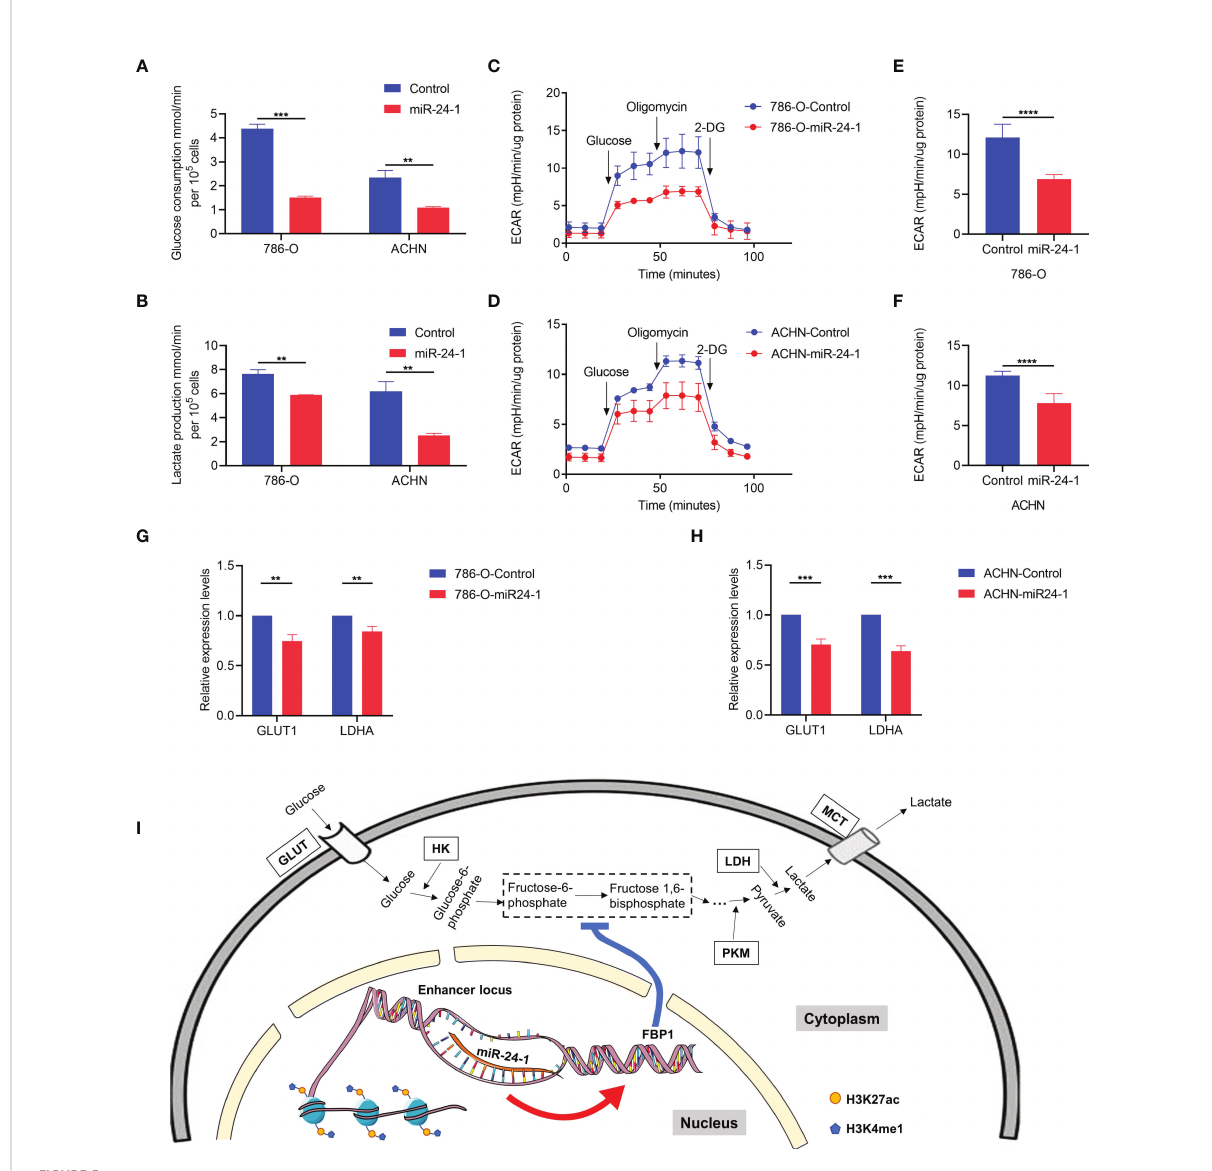
FIGURE 5 FBP1 suppresses Warburg effect in RCC cells. (A) Quanti fi cation of glucose consumption in miR-24-1-overexpressing 786-O and ACHN cells. (B) Lactate production in 786-O and ACHN cells transfected with miR-24-1 was measured by lactate assay. (C, D) Extracellular acidi fi cation rate (ECAR) of 786-O (C) and ACHN (D) cells was detected after miR-24-1 overexpression with glucose starved for two hours and subsequently treated with 2 g/L D-glucose, 1 m M oligomycin, and 100 mM 2-Deoxyglucose (2-DG). (E, F) ECAR represents maximum glycolytic capacity after oligomycin treatment of 786-O (E) and ACHN (F) cells. (G, H) qPCR analysis of glycolytic related genes in vector control or miR-24-1- overexpressing 786-O (G) and ACHN (H) cells. (I) Schematic diagram of FBP1 being activated by miR-24-1 to disturb Warburg effect in RCC cells. The enriched modi fi cations of H3K4me1 and H3K27ac represent active enhancer markers. Results are shown as mean ± S.D. of triplicated experiments, ****p < 0.0001, ***p < 0.001, **p <